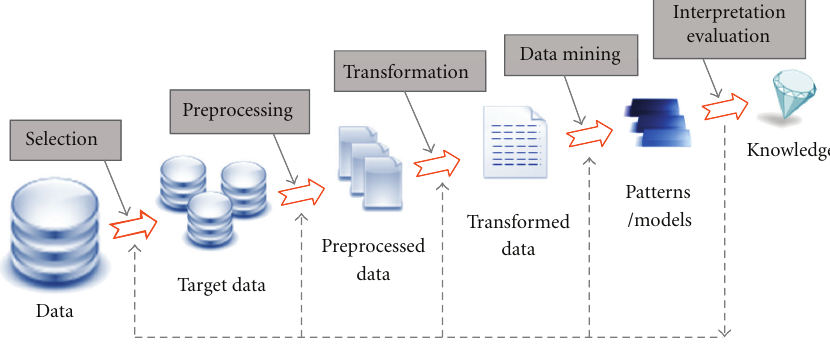
Figure 1: Knowledge discovery